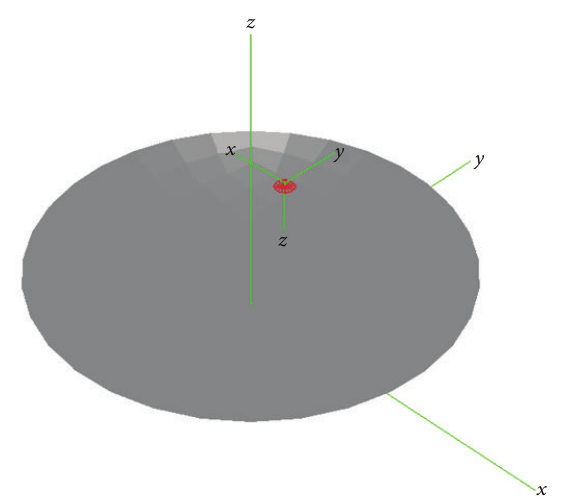
Figure 21: Single reflector with the horn shifted.